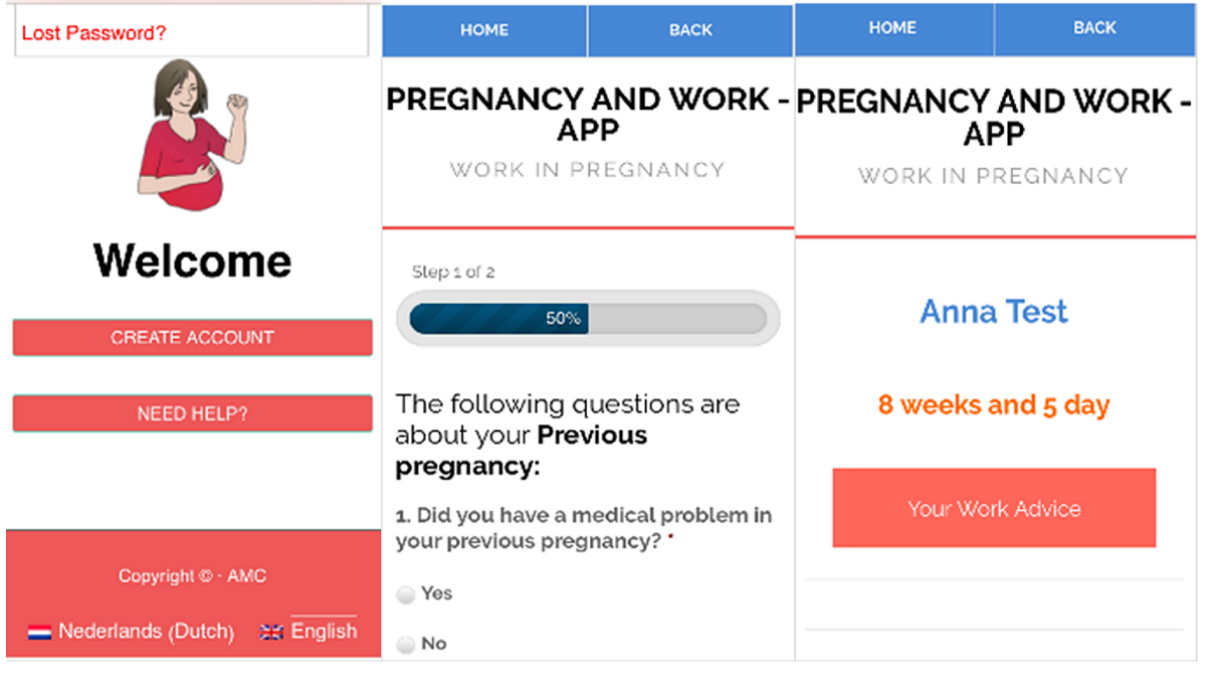
Figure 1. Examples of screenshots of Pregnancy and Work App: the Welcome page, the Questionnaire page, and the Work Advice page.